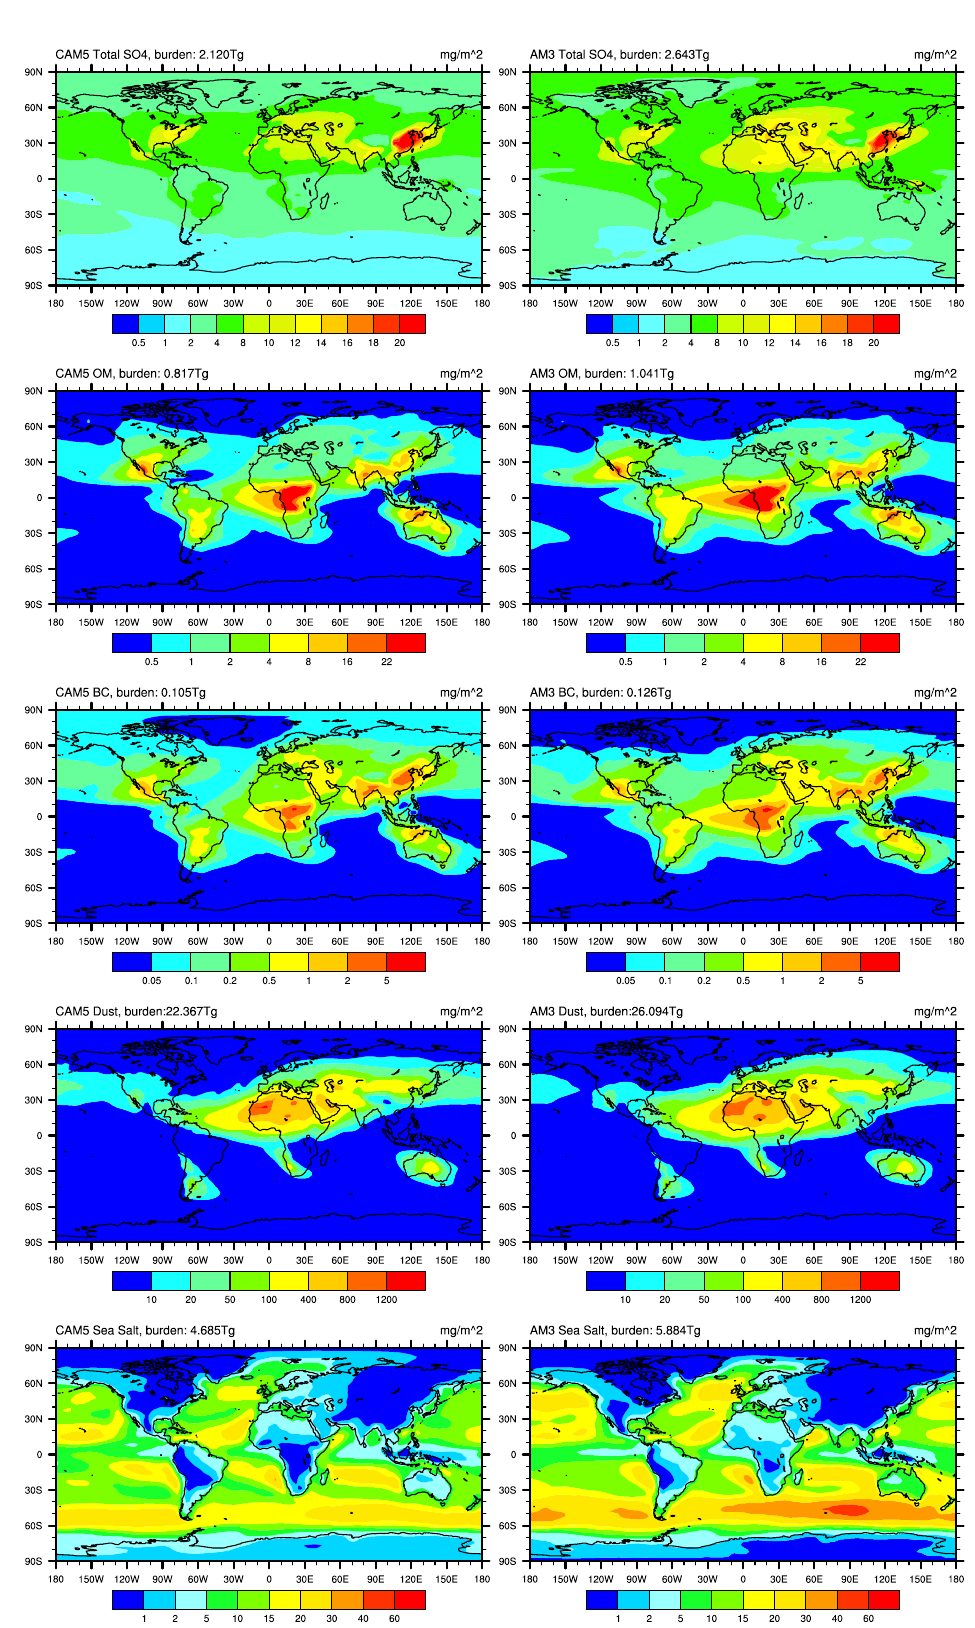
Fig. 6. Annual mean column integrated burden of sulfate, OM, BC, dust and sea salt (from top to bottom) from case C1 (left) and A1 (right). Atmos. Chem. Phys., 12, 9629–9652, 2012